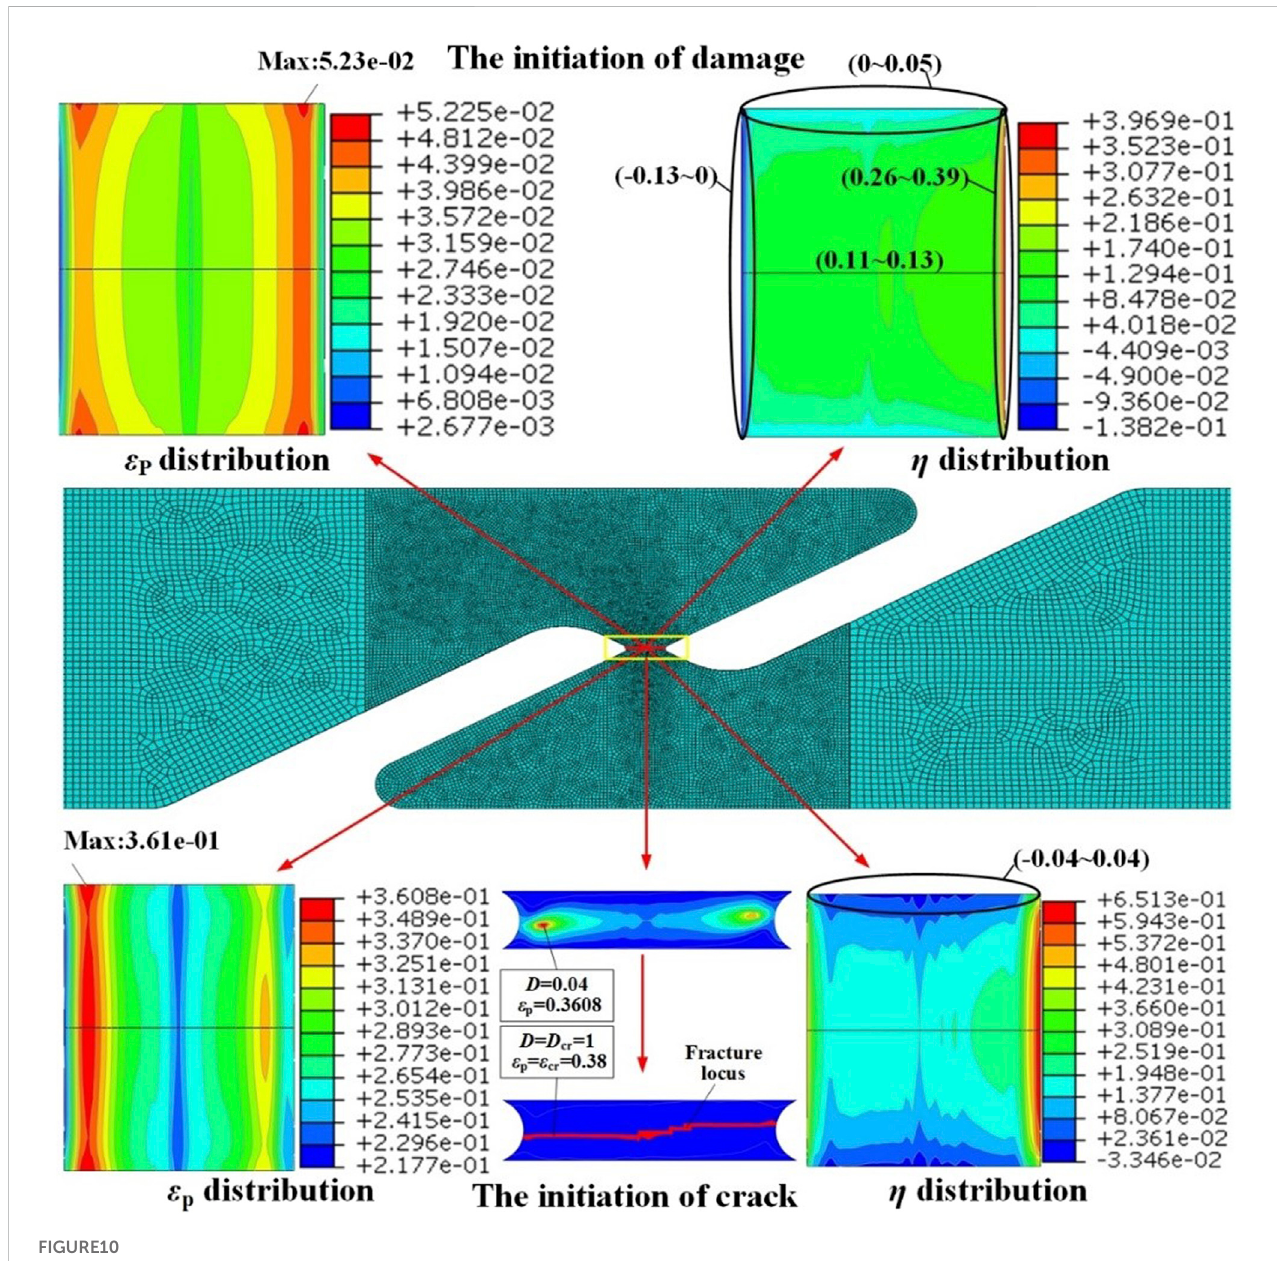
FIGURE10 Distributions of stress triaxiality and equivalent plastic strain for shear